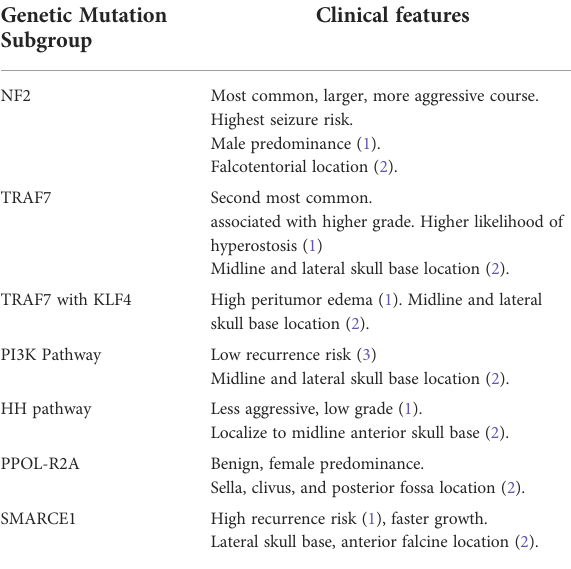
TABLE 1 Meningioma classi fi cation based on genetic